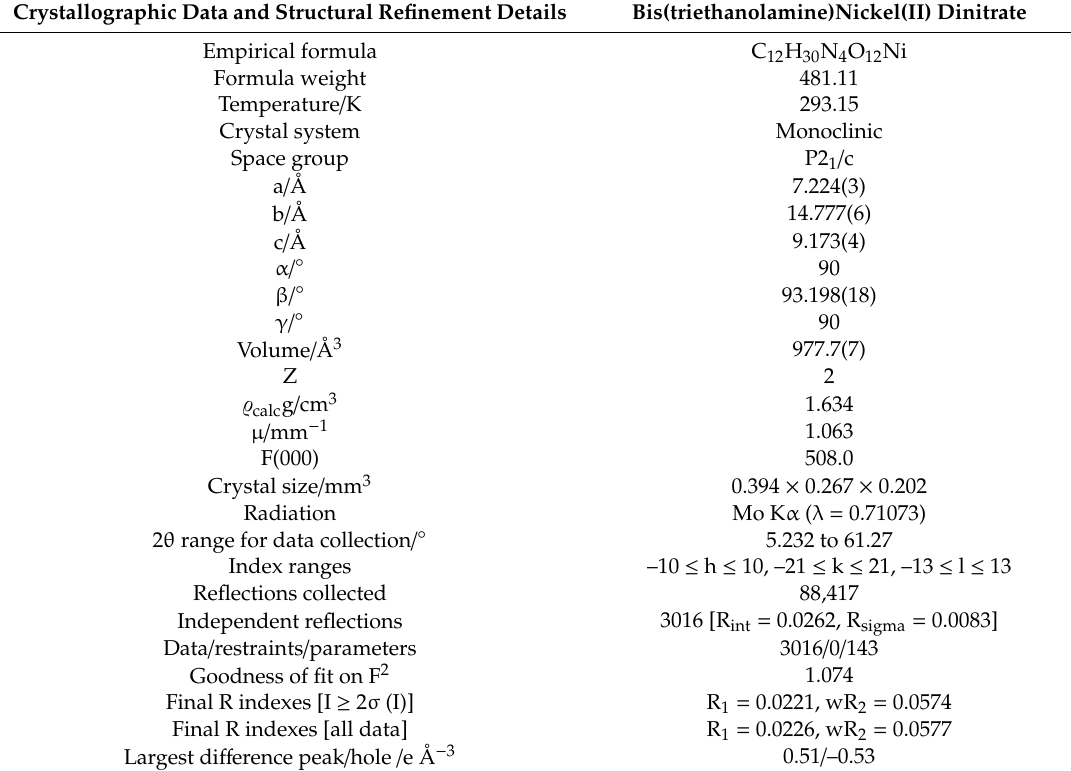
Table 1. Crystal data and structure refinement details for bis(triethanolamine)nickel(II) dinitrate complex (Ni-TEA